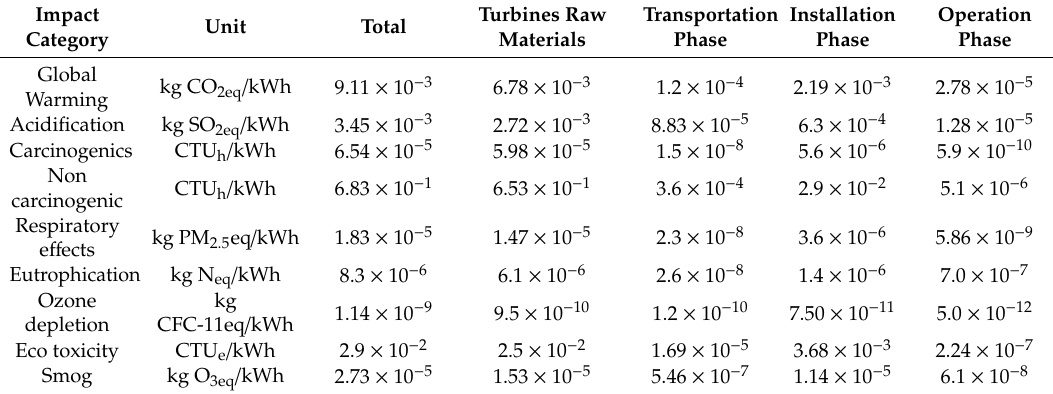
Table 13. The environmental impacts of generating 1 kWh of electricity during a 20-year lifespan - Part Impact Category